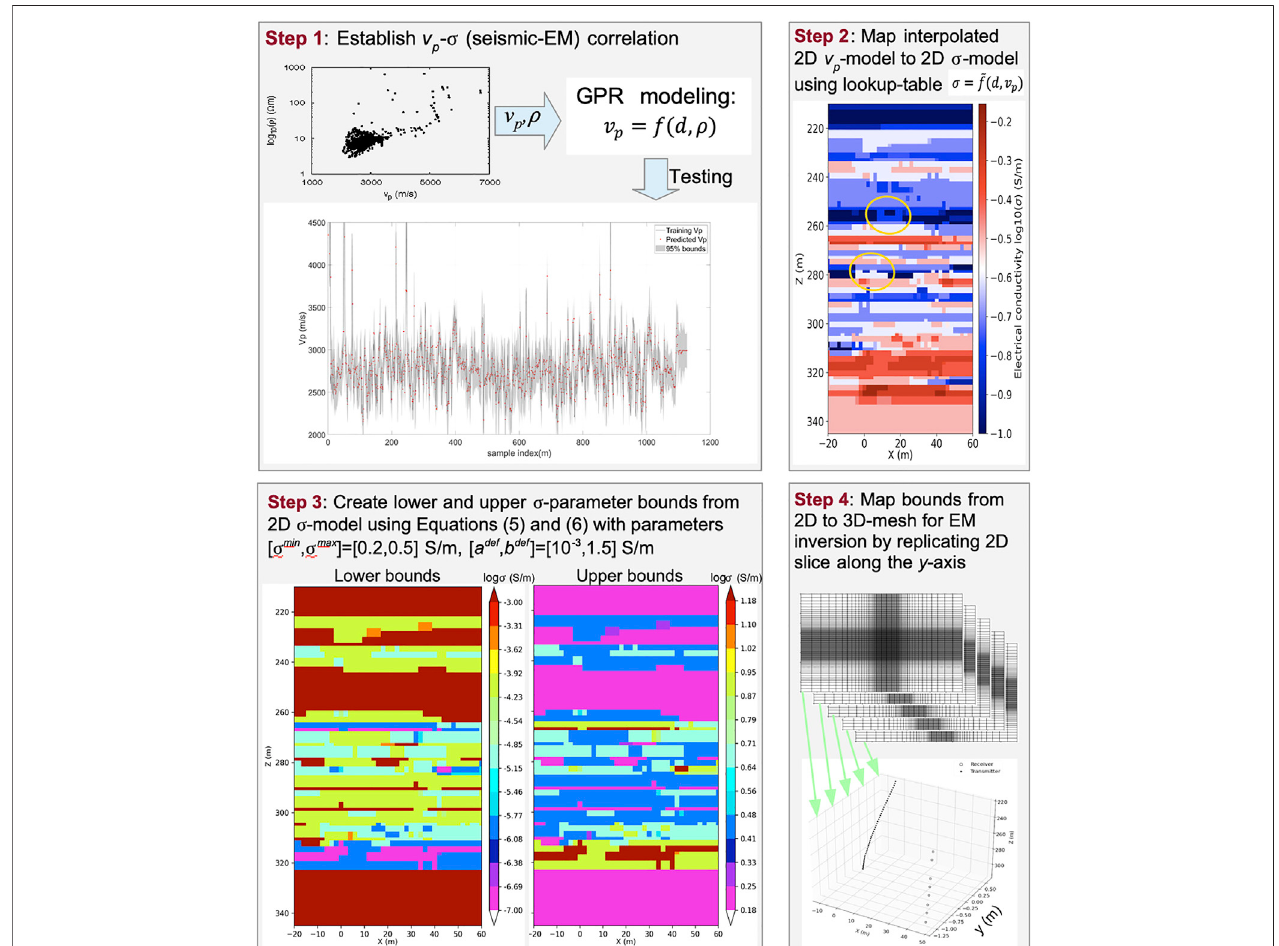
FIGURE10| Work fl owforcreationofspatiallyvariable3DlowerandupperconductivityparameterboundsforCaMI.FRS fi elddatainversion.Lowerboundshavea default(maximum)valueof a def (cid:2) 10 − 3 S/manddecreasetoaminimumof a min (cid:2) 10 − 7 S/minprede fi nedareasofinterest.Upperboundshaveadefault(minimum)value of b def (cid:2) 1 . 5 S/mandincreasetoamaximumof b max (cid:2) 15 S/minthesameareasofinterest.Ellipses(orange)intheimageofStep2indicateregionswithslightdeviations from a predominantly horizontally layered